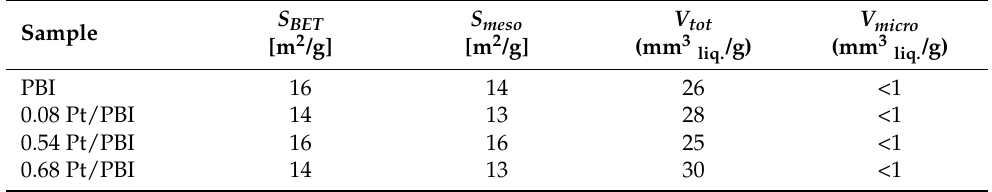
Table 1. Textural characteristics of the parent electrospun membrane and